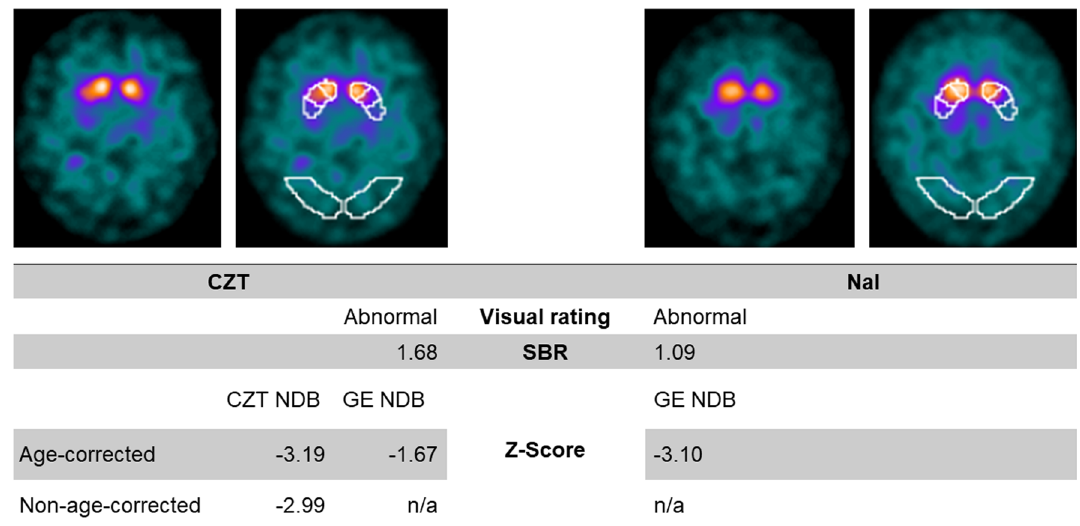
Fig. 4 FP-CIT SPECT images of a 65-year-old male first acquired on a NaI (right) and directly afterward on a CZT (left) system. The subject was visually rated as a neurodegenerative PS. For the CZT data, z-scores calculated with the CZT NDB corresponded with the visual assessment, whereas the utilization of the GE NDB resulted in discordance. Semiquantitative results of the NaI system were in line with the visual rating